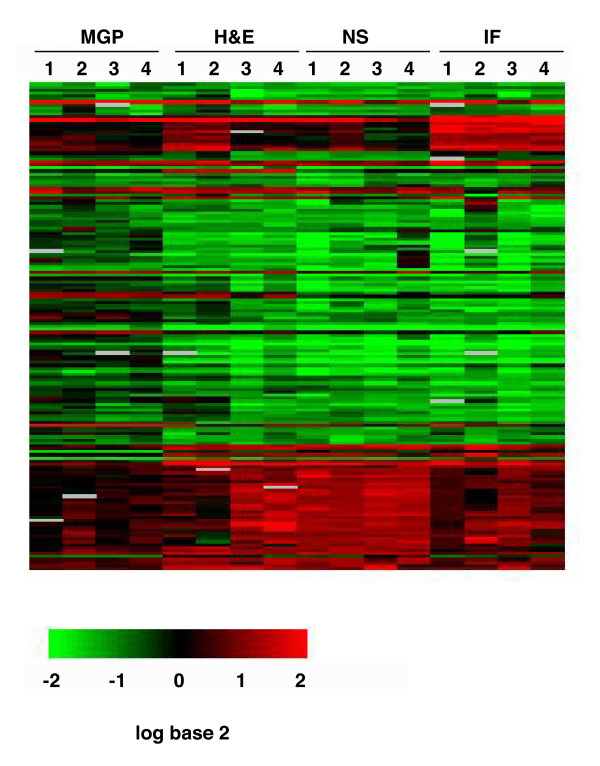
Log-ratios of genes significantly different between A (cell pellet) and LCM samples where genes are sorted according to the order of a dendrogram generated by clustering over genes. Red shades correspond to higher expression in the staining group than A; green shades correspond to lower expression; and black indicates no difference.